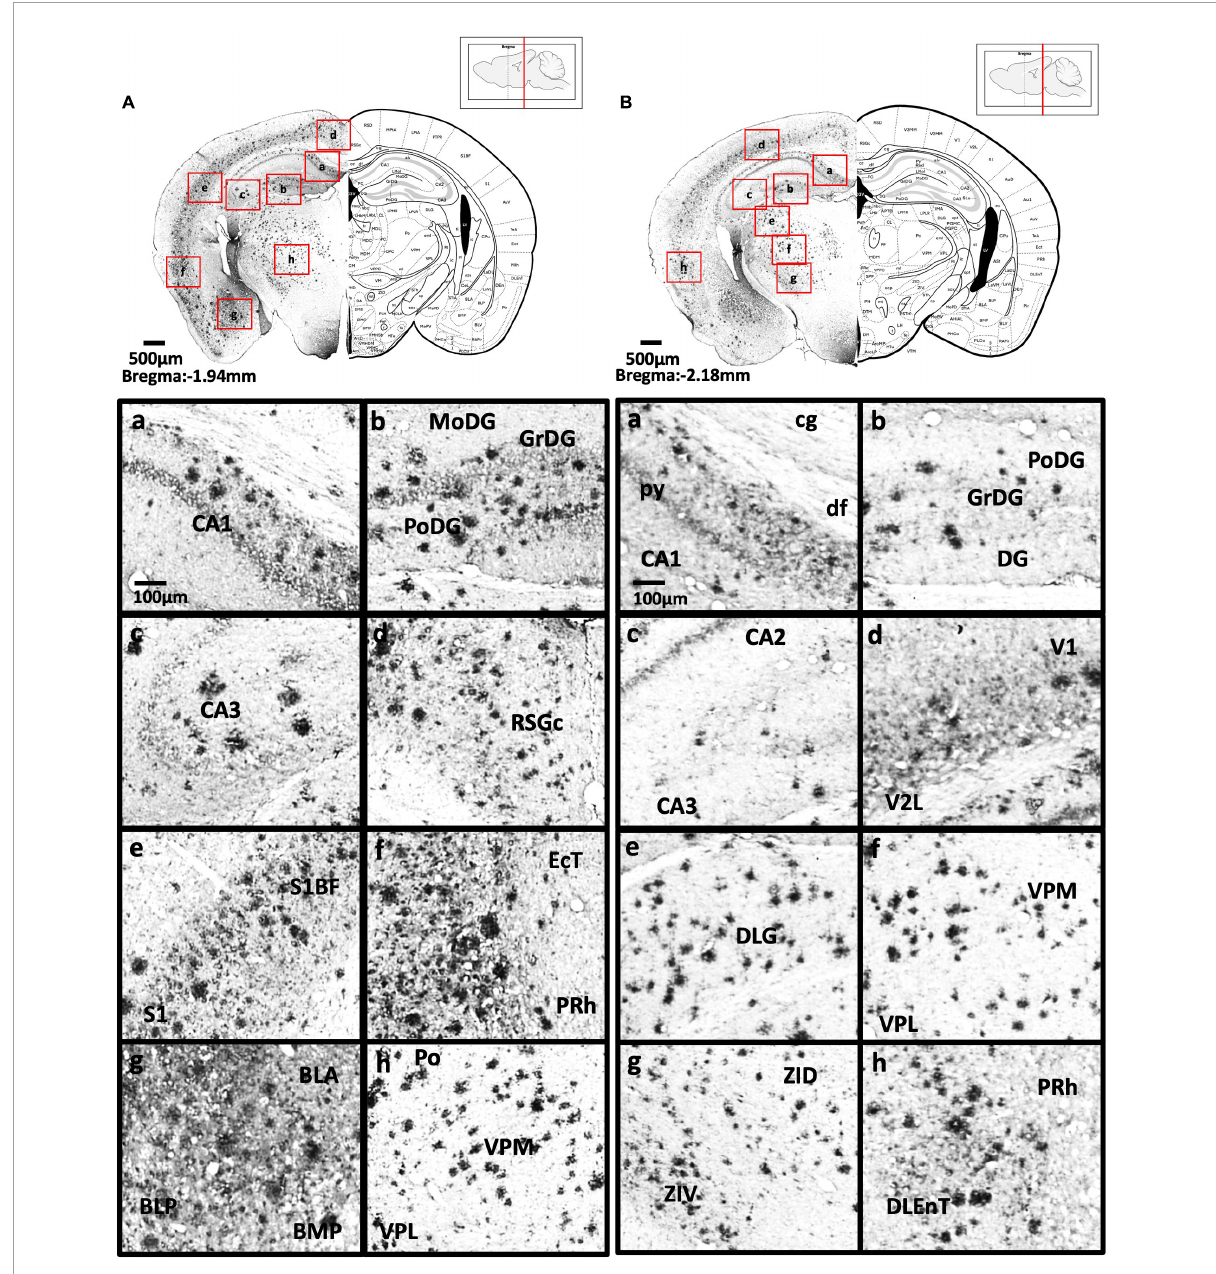
FIGURE5 (A) Coronal section through the forebrain showing A β deposition in CA1 field (a), dentate gyrus (b), CA3 field (c), C region of the retrosplenial granular cortex (d), barrel field of the somatosensory cortex, primary somatosensory cortex (e), ectorhinal cortex, perihinal cortex (f), anterior and posterior basolateral amygdaloid nucleus, posterior basomedial amygdaloid nucleus (g), and posterior, ventral posterolateral and ventral posteromedial thalamus (h). (B) Coronal section through the forebrain showing A β deposition in the cingulum, pyramidal tract, dorsal fornix and CA1 field (a), dentate gyrus (b), CA2, CA3 (c), primary visual cortex and secondary lateral visual cortex (d), dorsal lateral geniculate nucleus (e), ventral posterolateral and ventral posteromedial thalamus (f), dorsal and ventral part of zona incerta (g), perihinal cortex, and dorsolateral entorhinal cortex (h).